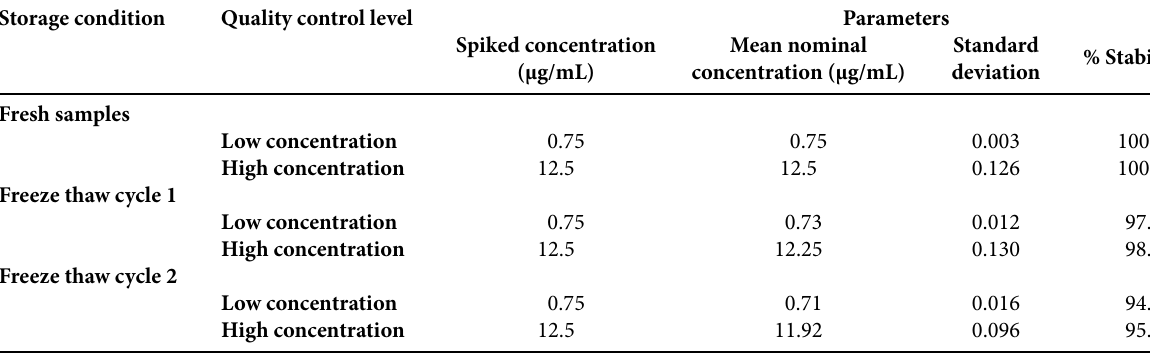
Table 4. Freeze-thaw stability of quality control